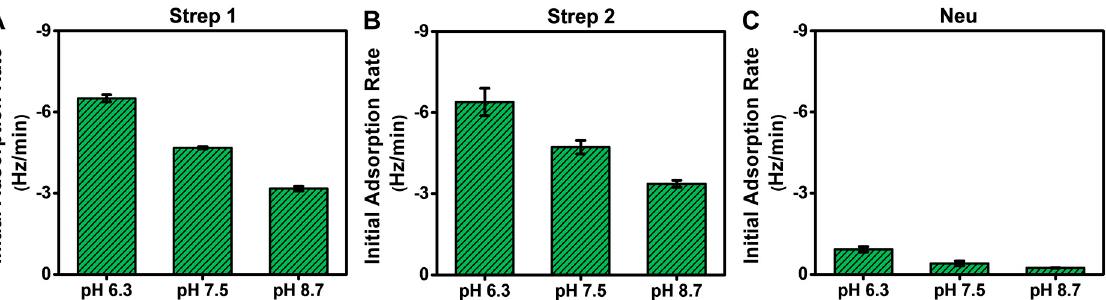
Figure 6. Initial adsorption rates for Neu and Strep protein binding to biotinylated SLBs in different pH conditions. The initial adsorption rates were calculated based on the time-dependent slope of the corresponding QCM-D Δ f shift during the first 10 min of adsorption in all tested pH conditions for ( A ) Strep 1, ( B ) Strep 2, and ( C ) Neu. The rates are reported as the mean ± standard deviation from n = 3 experiments.